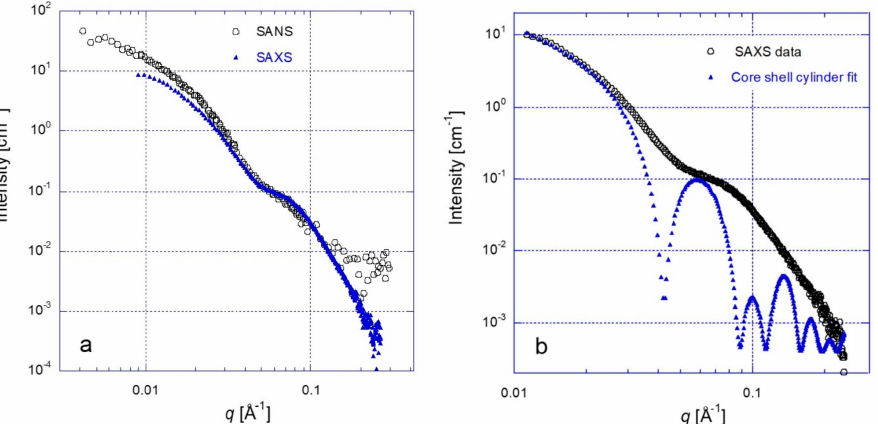
Figure 12. Scattering patterns of 0.5 wt.% MWCNT + 1 wt.% dS 11.5 -4VP 11.3 dispersions in 10 wt.% DMF-d7 solvent dispersion obtained by: ( a ) SANS and SAXS (data adjusted to the SANS intensity scale); ( b ) fit of the core–shell cylinder model to the SAXS data (one adjustable parameter: n ).